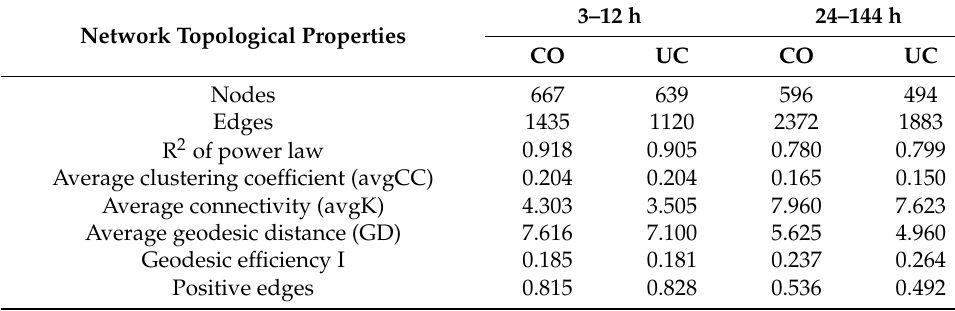
Table 2. Network topological properties of CO and UC networks. Network Topological